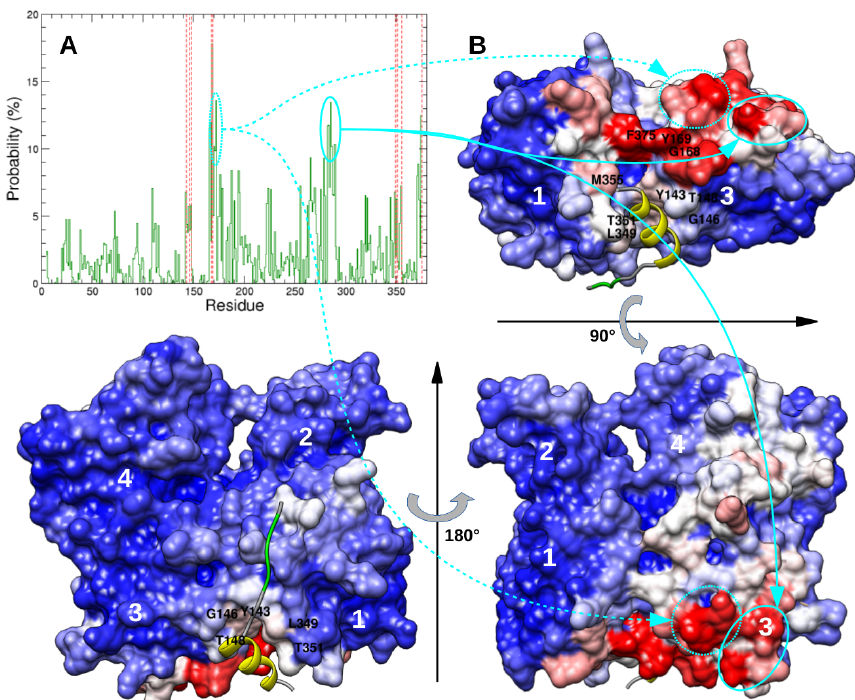
Figure 2. ( A ) Probability of actin residues to be distant by less than 4 Å from domain V regions 9–18 or 37–46. Red dashed lines indicate actin residues in contact with N-WASP helical segment in structure 2VCP [27]. ( B ) Views of actin’s surface colored proportionally to previous probabilities. Blue, white, and red colors indicate actin residues with low, intermediate, and high probabilities to be contacted by domain V, respectively. As a reference, yellow and green ribbons represent the second WH2 motif helical region and conserved sequence LKSV as observed in 2VCP